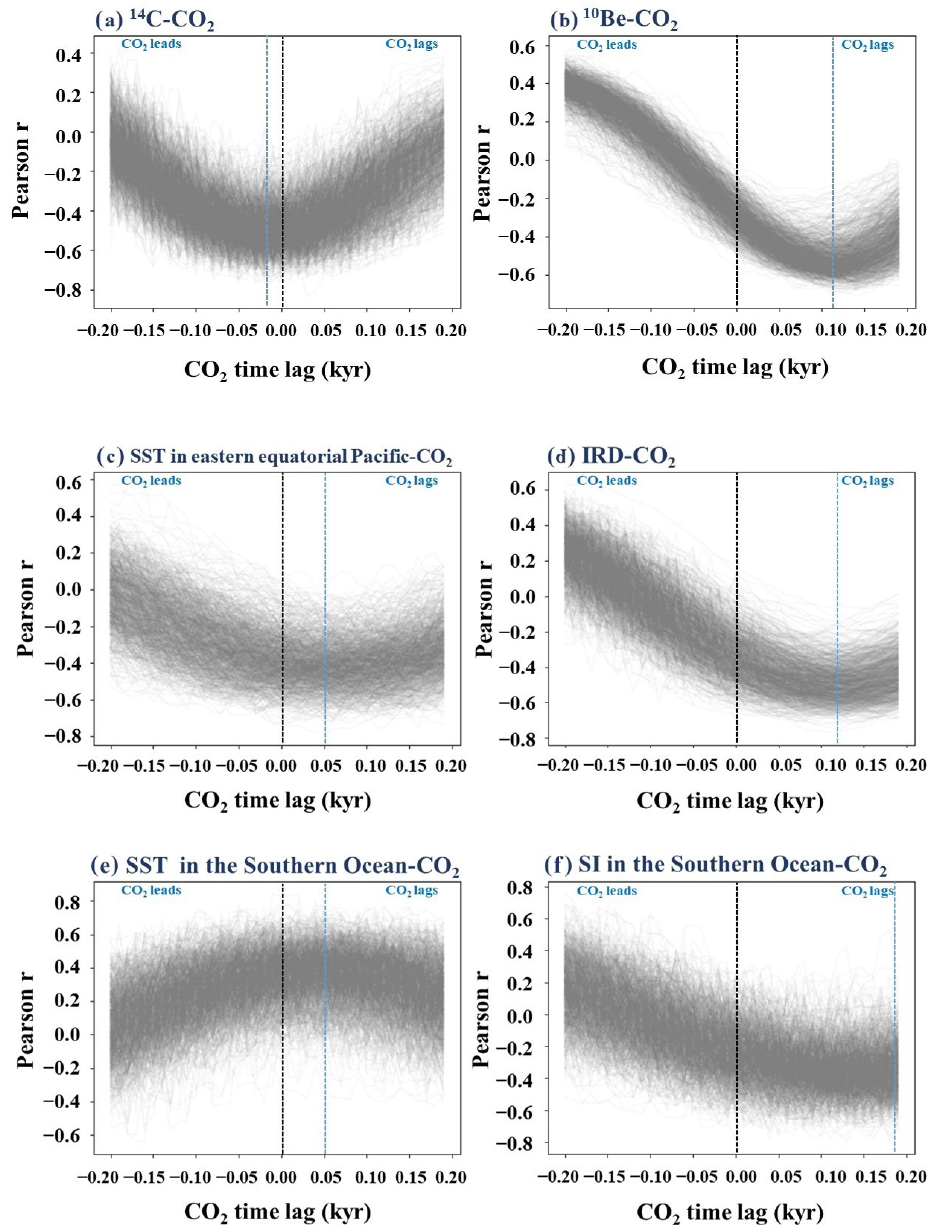
Figure 4. Correlation coefficients between CO 2 and proxies with CO 2 time lag calculated from Monte Carlo simulation. Vertical lines in black indicate zero time lag. Vertical lines in blue indicate maximum correlation coefficients between CO 2 and proxies with CO 2 time lag. (a) 14 C production rate and atmospheric CO 2 . (b) 10 Be flux and atmospheric CO 2 . (c) SST in the eastern equatorial Pacific and atmospheric CO 2 . (d) IRD from the North Atlantic and atmospheric CO 2 . (e) SST in the eastern equatorial Pacific indicating El Niño-like or La Niña-like conditions and atmospheric CO 2 . (f) SI in the eastern equatorial Pacific and atmospheric CO 2